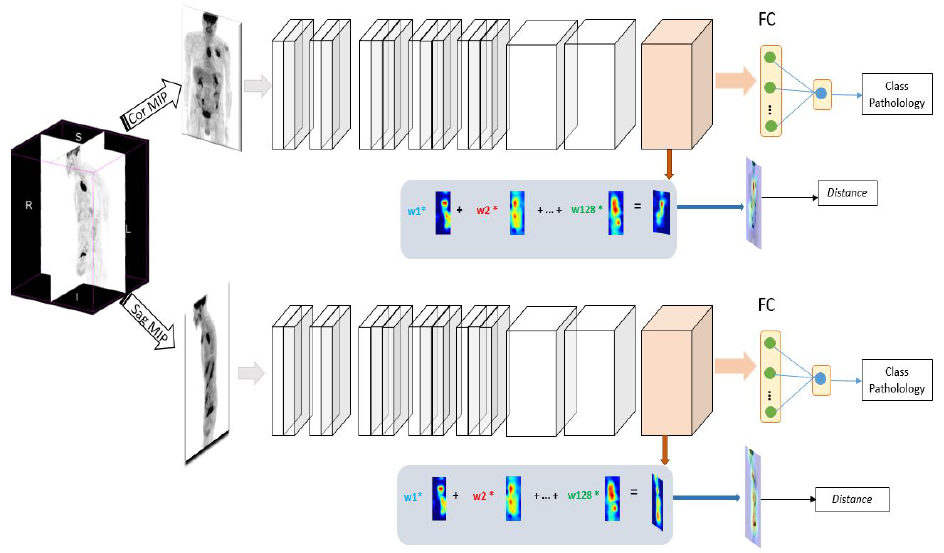
Figure 5. Our proposed architecture. The neural network learns to classify the type of cancer from two 2D MIP images (sagittal and coronal). The generated heatmap is back-propagated and corrected to identify accurately tumor